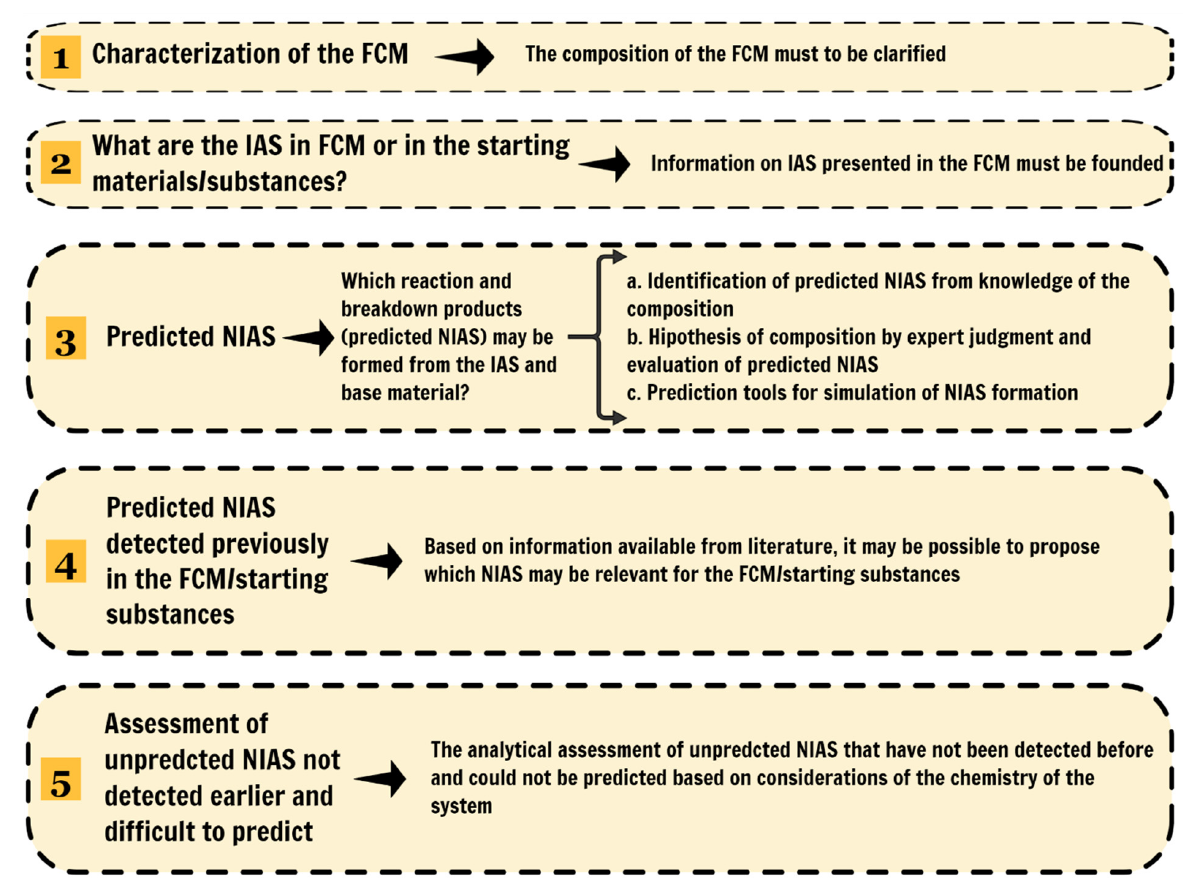
Figure 4. Steps approached by trying to identify predicted/unpredicted NIAS. After that, the next step is to identify the predicted NIAS from the IAS knowledge present in the FCM, e.g., reaction/breakdown products formed from the IAS and base ma- terials. Moreover, the guidance strongly recommends the literature survey to predict